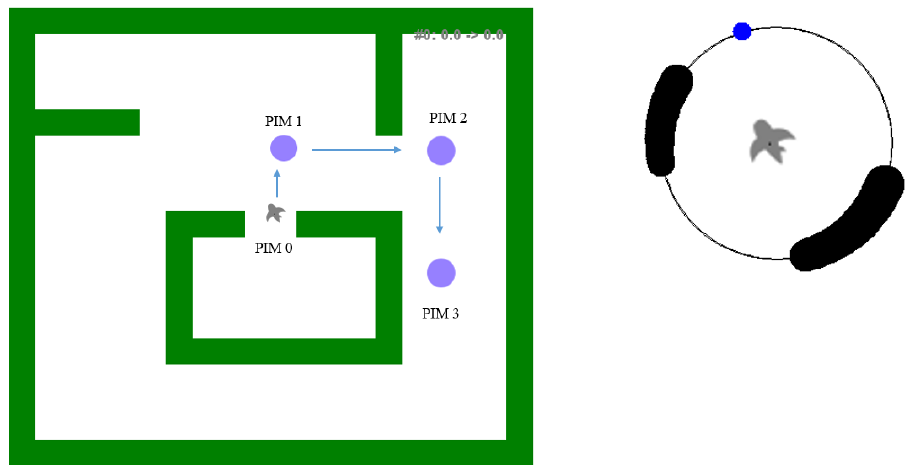
Figure 13. Simulated maze. On the left : the initial position of the avatar (“a bird”) in the labyrinth. The next targets (PIM1, PIM2, and PIM 3) to reach are represented by a violet circle. PIM 3 is the destination. On the right : the representation of the environment on the TactiBelt matching the avatar’s initial position: in black, the presence of nearby obstacles; in blue, the direction of the target to reach (colors represent different patterns of vibrations); the avatar is in the TactiBelt